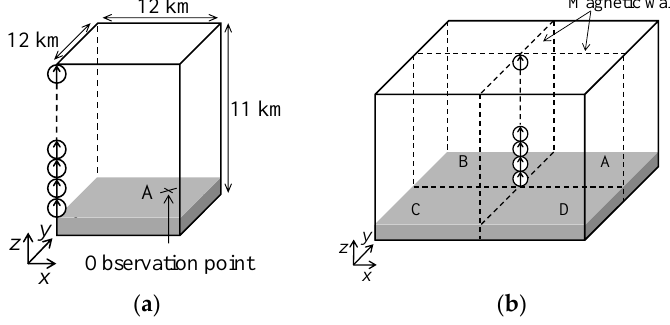
Figure 1. FDTD simulation model of a vertical lightning channel above flat, perfectly-conducting ground: ( a ) a single quadrant model with two magnetic walls; and ( b ) its equivalent four-quadrant model.